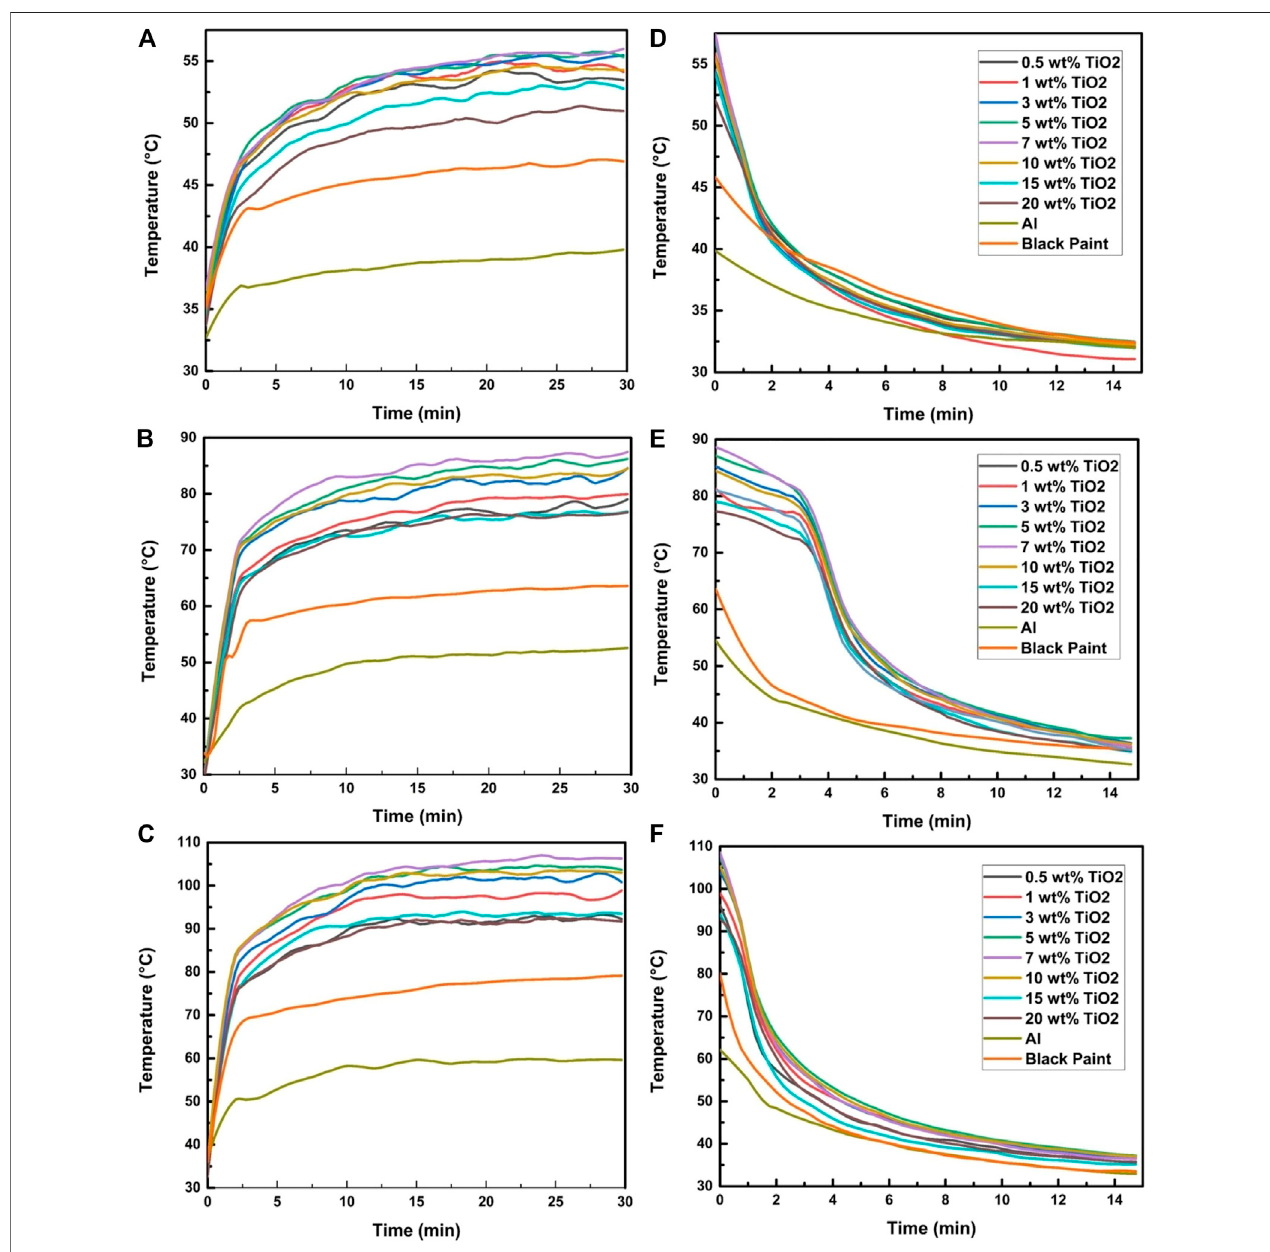
FIGURE 6 | Effect of TiO 2 -400 nm on the absorber temperature at irradiation exposure of (A) 200 W/m 2 , (B) 600 W/m 2 , and (C) 1,000 W/m 2 and (D – F) temperature drop pro fi le.